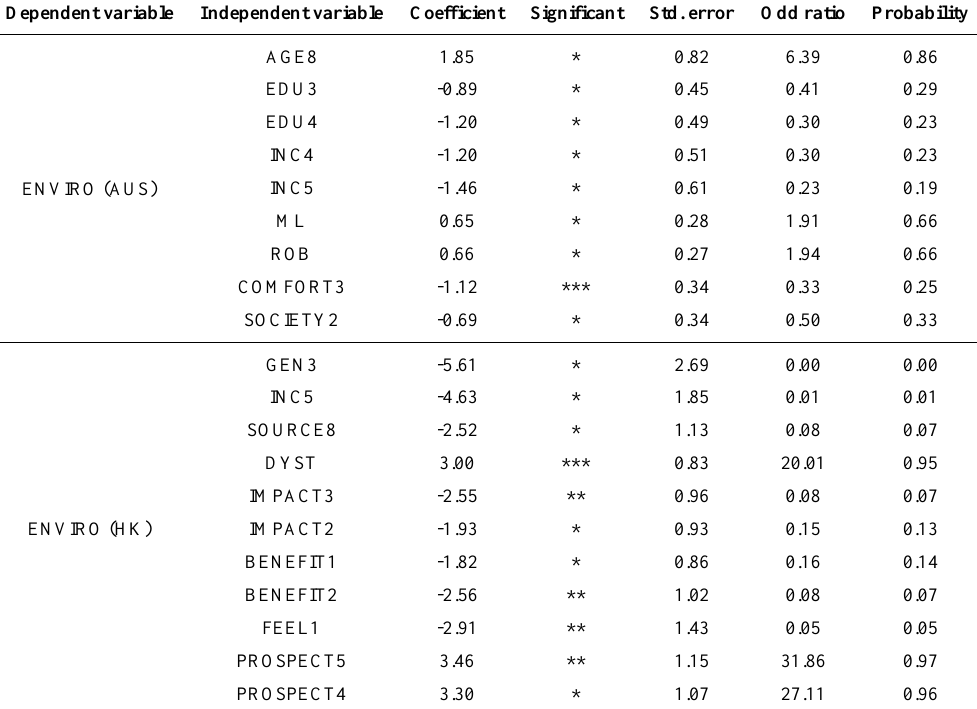
Table A-9. Environmental conservation and heritage protection